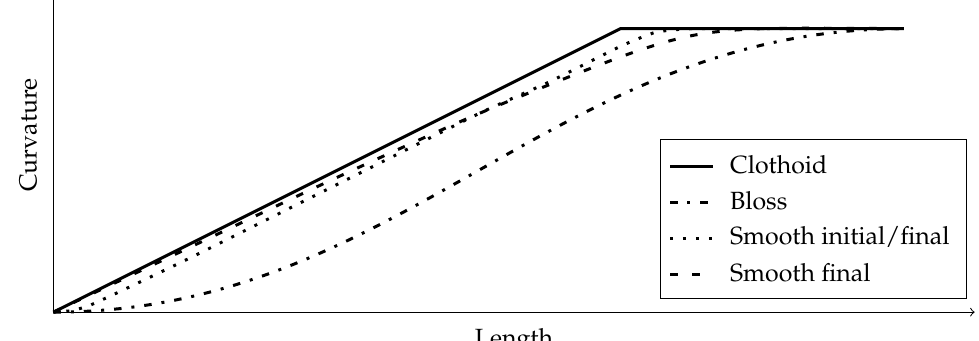
Figure 5. Curvature diagram for the clothoid, Bloss curve, Koc’s curve with smoothed initial and final regions and Koc’s curve with smoothed final